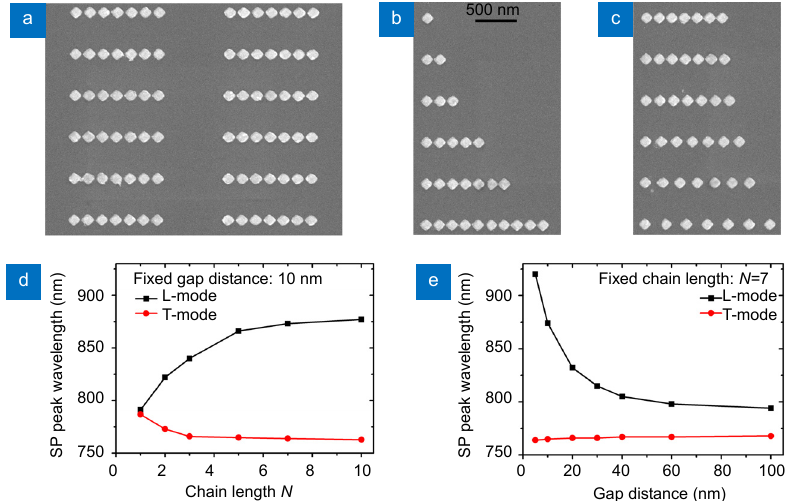
Fig. 1 | ( a ) SEM image of an array of Au nanochains on a Nb-doped TiO 2 substrate. ( b, c ) SEM images of nanochains with different chain lengths (b) and gap distances (c), respectively. ( d, e ) Plots of the L-mode and T-mode surface plasmon resonance peak wavelengths as a function of the chain length (d) and the gap size